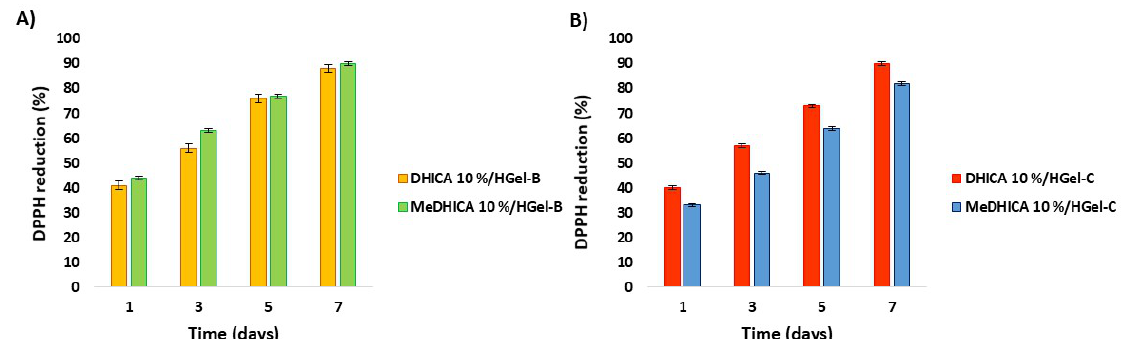
Figure 11. Reduction of DPPH by HGel-B ( A ) or HGel-C ( B ) loaded with DHICA or MeDHICA at 10%. Reported are the mean ± SD values of three experiments .